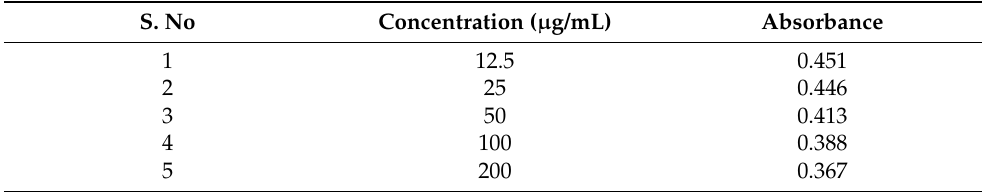
Table 5. Concentration vs. absorbance of cell viability of test and control.